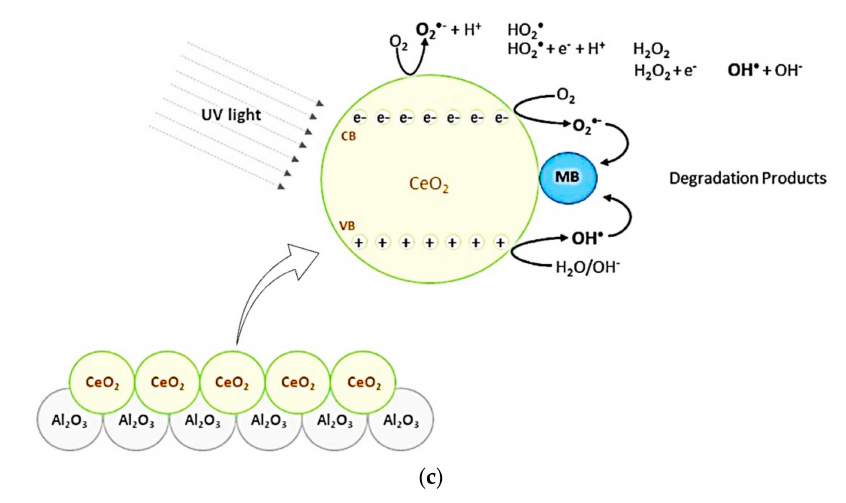
Figure 6. Example of recent studies on supported material photocatalyst such as ( a ) graphene [65], ( b ) carbon nanotube [68], and ( c ) aluminum oxide [70].